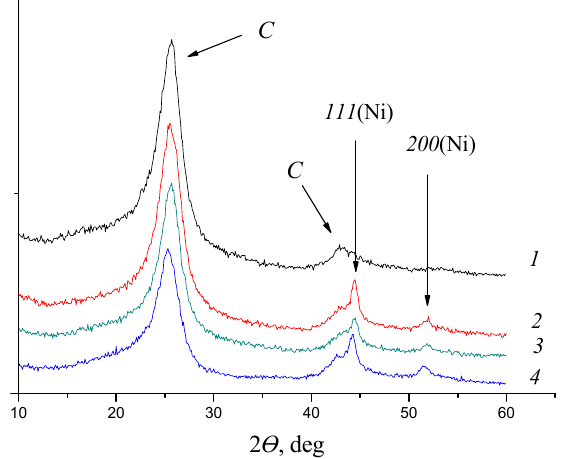
Figure 4. Diffraction patterns of С ox and Ni-catalysts: 1— С ; 2—Ni/C; 3—Pt/Ni/Cr/C; 4 –Pt/Cr/Ni/C.